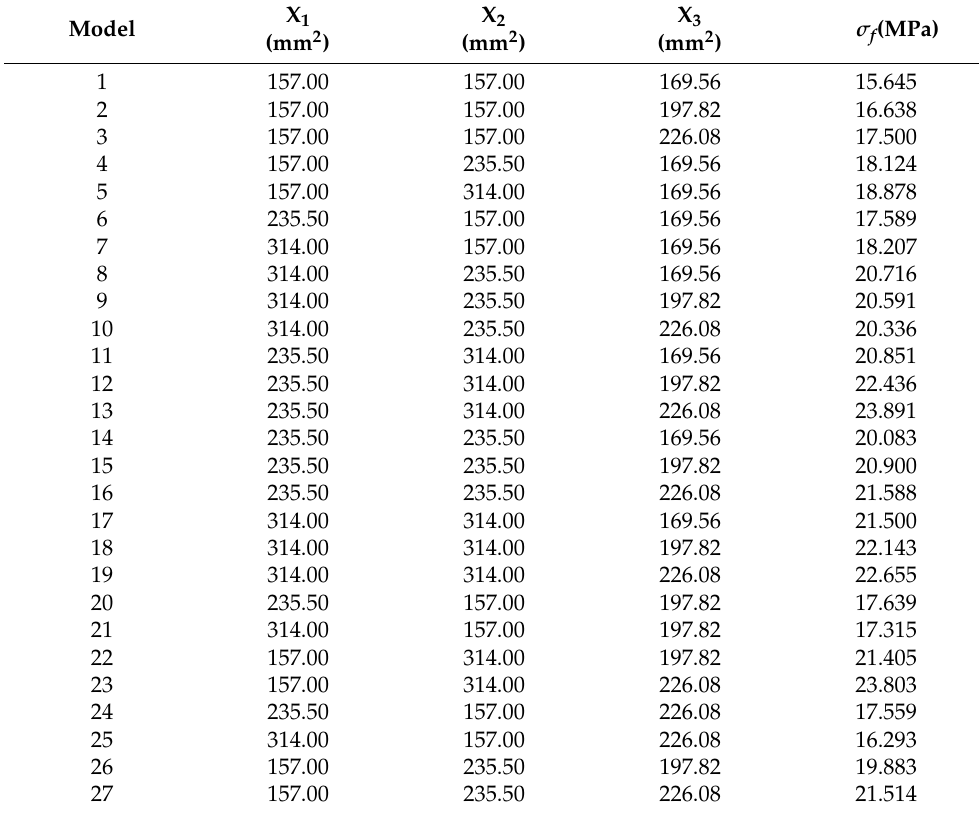
Table 11. Optimization results for flexural stress.